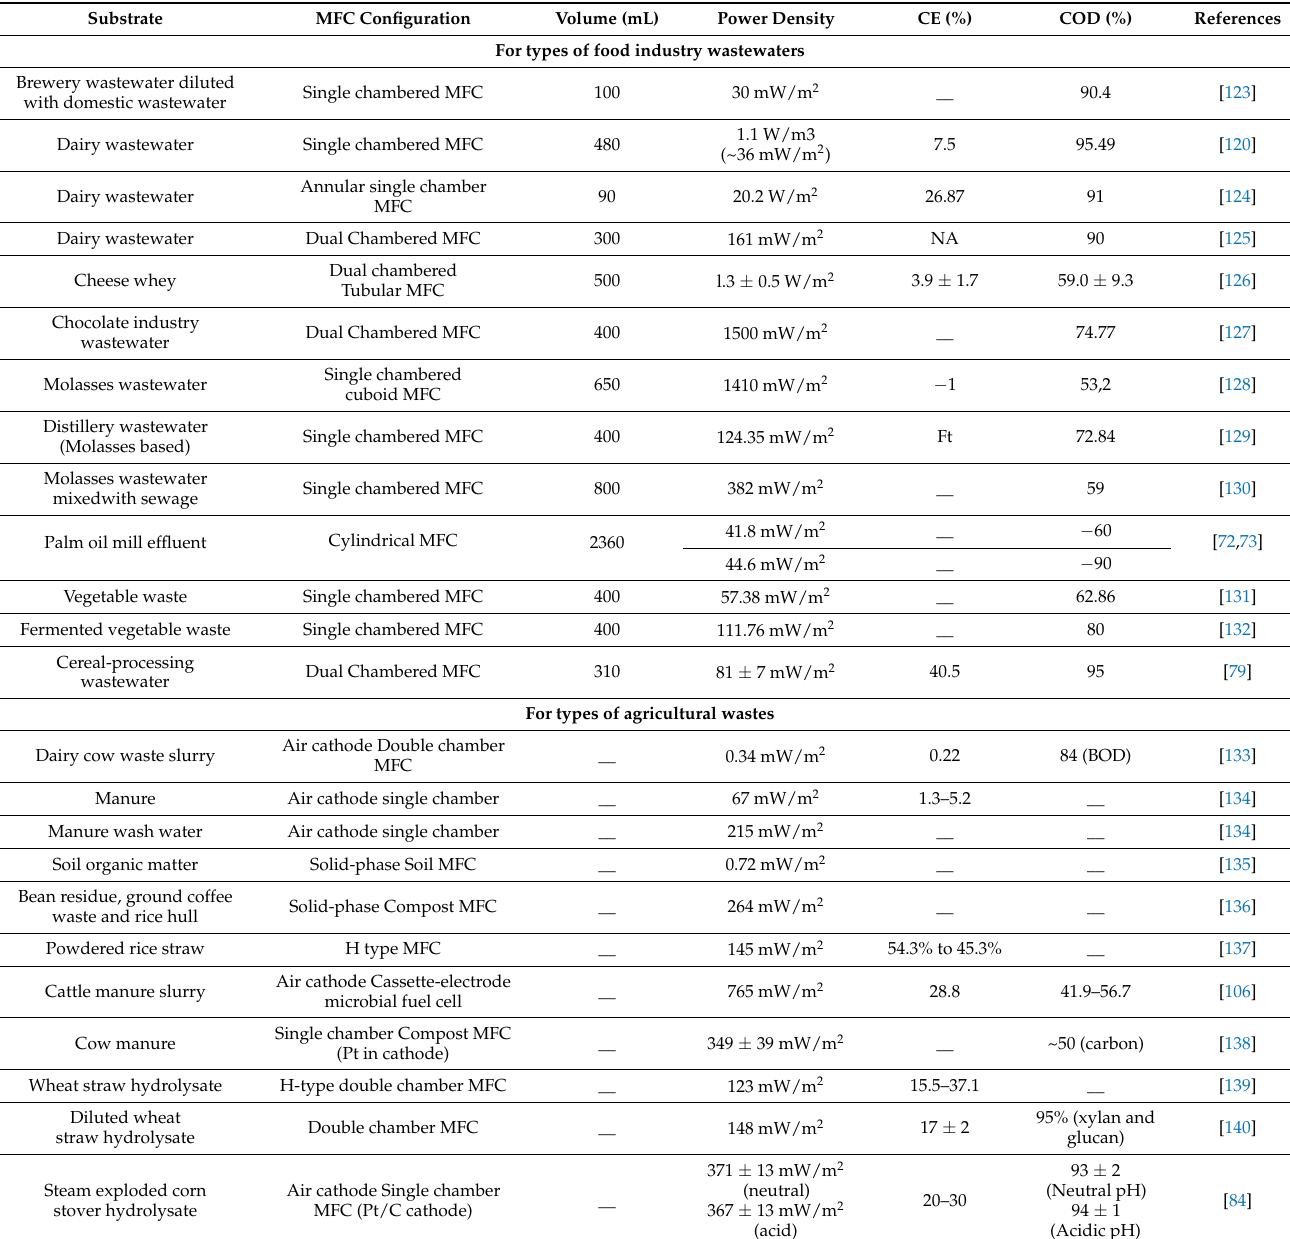
Table 3. MFC efficiency is based on various